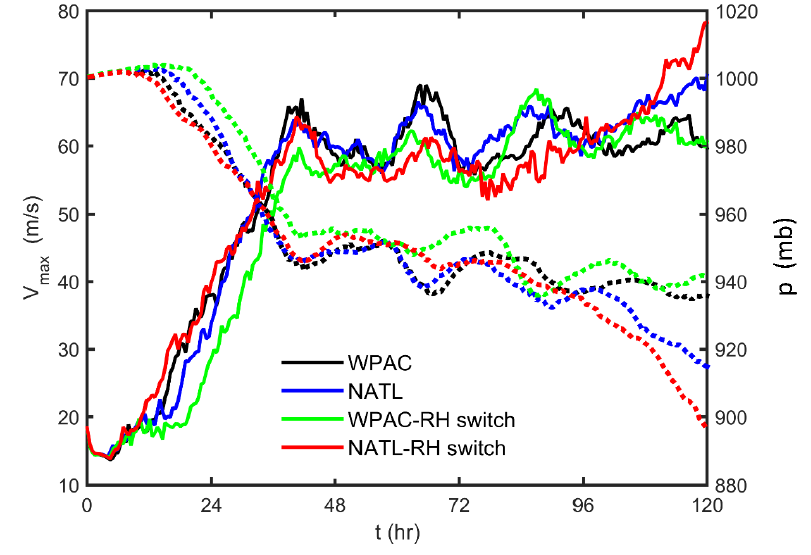
Figure 4. Time series of the HWRF-simulated minimum central pressure (dotted, hPa) and the maximum surface wind (solid, m s − 1 ) for the WPAC-CTL experiment (black), the NATL-CTL experiment (blue), WPAC experiment with the NATL moisture profile (green), and the NATL experiment with the WPAC moisture profile (red).